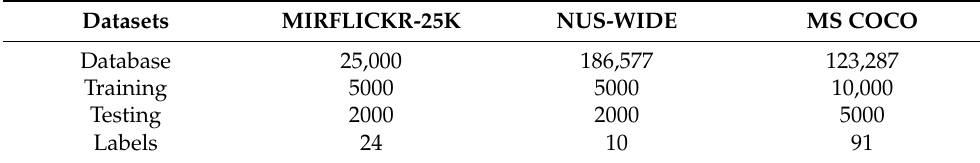
Table 1. The Statistics of Three Cross-modal Retrieval Benchmark